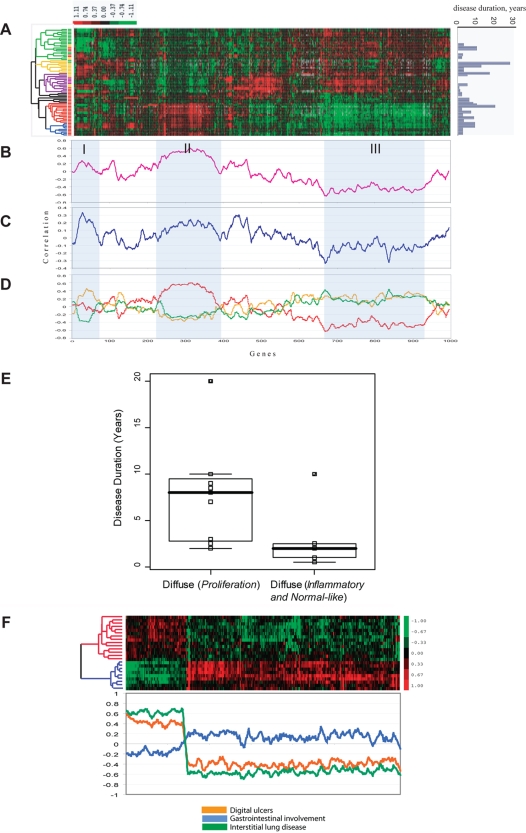
Correlation between gene expression and clinical covariates.A. Shown is the color-coded heatmap of the 75 arrays and 995 intrinsic genes. The graph on the right of the heat map shows disease duration for each sample. Disease duration was set to zero for normal controls and morphea samples. B. Pearson correlations were calculated between skin score and the expression values for each gene in the list. The moving average of the Pearson correlation (10-gene window) was plotted. Regions of high negative and high positive correlations to the three different clinical parameters are indicated (regions I–III shaded grey). C. Moving average of the Pearson correlation coefficients (10-gene window) between the self-reported Raynaud's severity score and the expression of each gene, D. Moving average of the Pearson Correlations (10-gene window) between extent of skin involvement and a diagnosis vector (see Methods) for dSSc(red), lSSc (orange) and healthy controls (green). E. Box plot of disease duration for dSSc patients. The patients included in the diffuse-proliferation group had disease duration of 8.4±6.4 years. The dSSc patients that fell into the inflammatory or normal-like groups have disease duration of 3.2±3.9 yrs (p<0.12, t-test). F. Genes that ideally discriminate ‘Diffuse 1’ and ‘Diffuse 2’ groups were selected using Significance Analysis of Microarrays (SAM). 329 genes were selected with an FDR<1%. Pearson correlation coefficients were calculated between each clinical parameter and the expression for each gene and plotted as a 10-gene moving window.